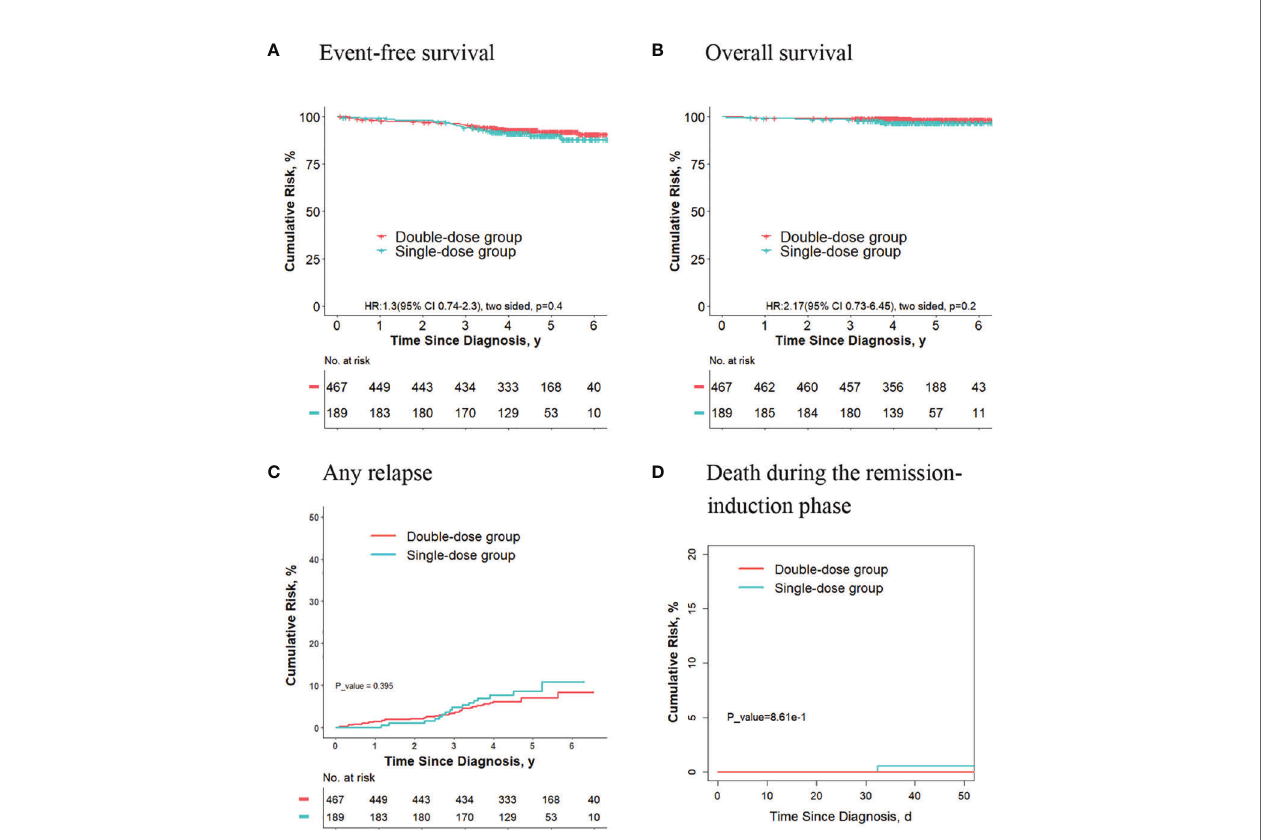
FIGURE 4 | Analysis of survival and cumulative risk of relapse and early death for fi nal low-risk patients with ETV6-RUNX1 -positive